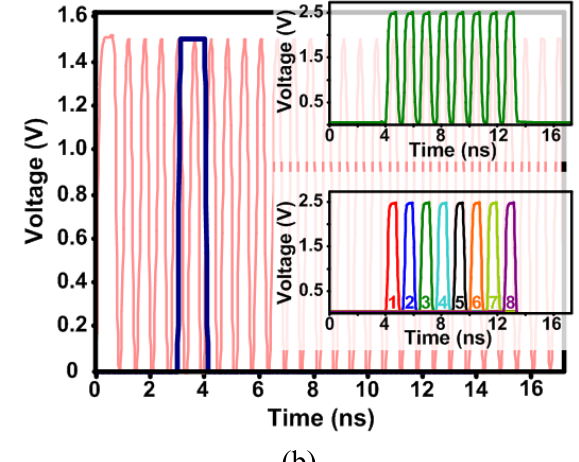
Figure 11. (a) Schematic diagram of the write and reset pulse generator circuit. (b) Simulation results of the write and reset pulse generator circuit showing the start pulse coming in at 3 ns with a clock frequency of 1.25 GHz. The top inset figure shows the 8 reset pulses (active low) and the bottom inset figure shows the generated 8 write pulse signals that have a width of 400